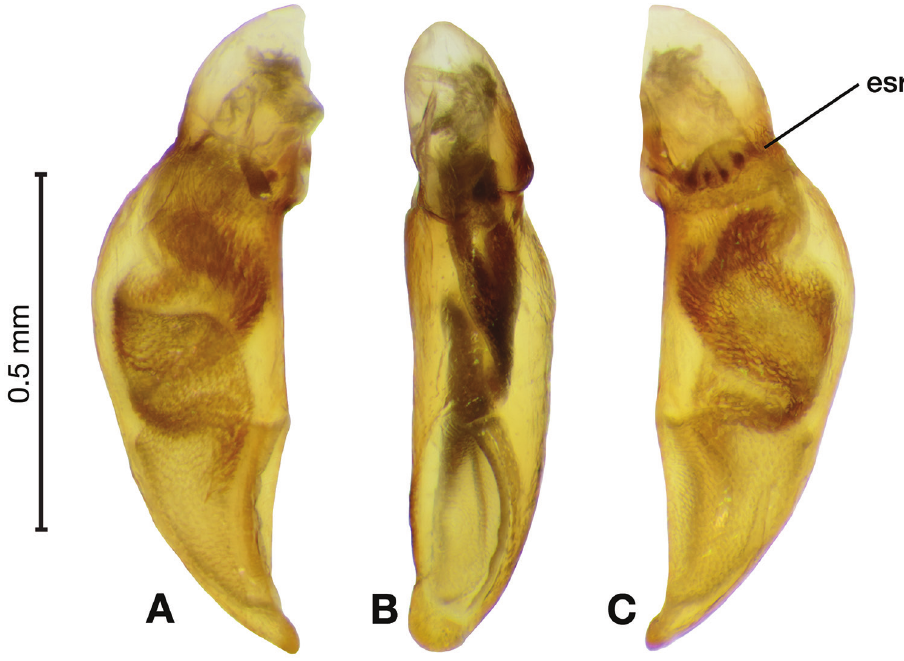
Figure 45. Digital images of male genitalia of C. ( Coptoderina ) maculata (Dupuis). A right lateral aspect B ventral aspect C left lateral aspect. Legend: esr endophallic sclerite